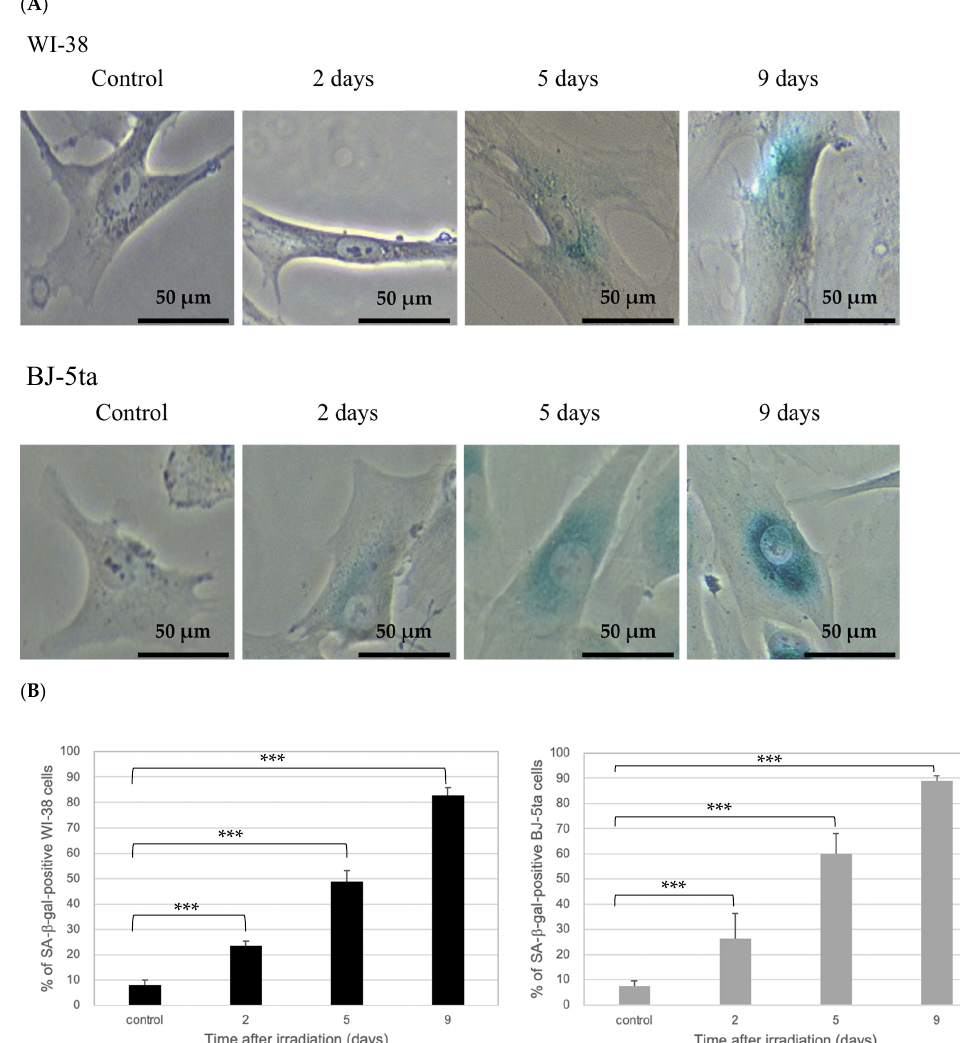
Figure 3. ( A ) Representative microscopic images of SA- β -gal-stained nonirradiated (control) and 20 Gy X-irradiated WI-38 and BJ-5ta cells observed under a fluorescence microscope at 20 × magnification. The images of the irradiated cells were taken at 2, 5, and 9 days after irradiation. Blue staining indicates irreversible cell-cycle-arrested cells. ( B ) The fraction of the SA- β -gal-positive WI-38 and BJ ‐ 5ta cells normalized by the total number of cells at each incubation time. Approximately 70 cells were scored in one microscopic field. The error bars represent the standard deviation. Statistical analysis was performed with one ‐ way ANOVA ( p < 0.001) plus a Student’s t ‐ test. The symbol * indicates the p ‐ values of the t ‐ test compared with the control and irradiated samples, respectively; *** p < 0.001.